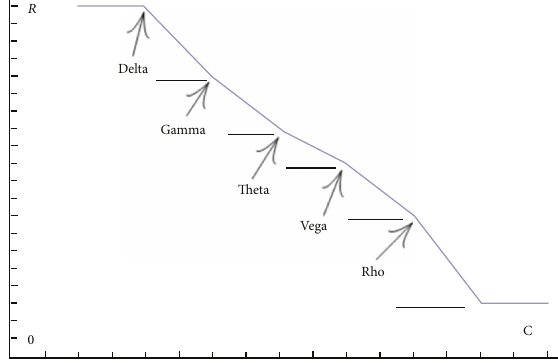
Figure 3: The risk changes under e ff ective control of